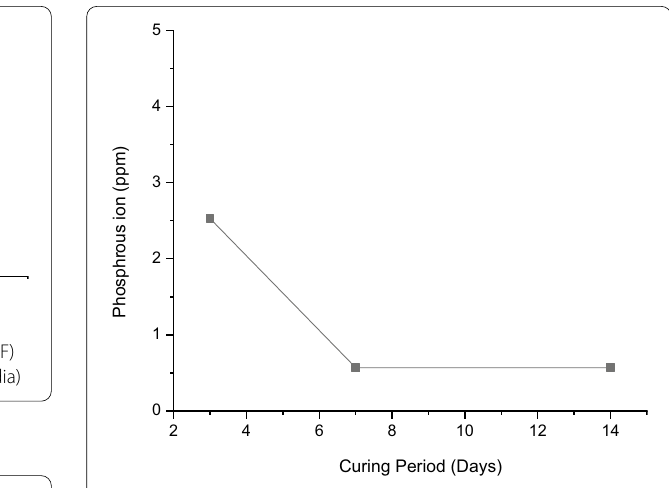
Fig. 6 Phosphorus ion concentration of Pseudomonas aeruginosa in Mueller Hinton Broth (MHB media) at different immersing periods